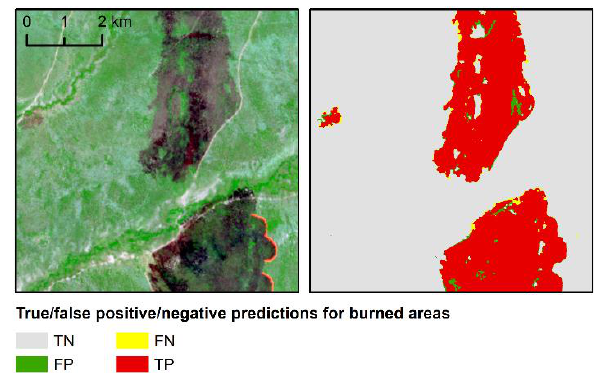
Figure 5 . Segmentation of burned areas in Central Africa (RGB composition: